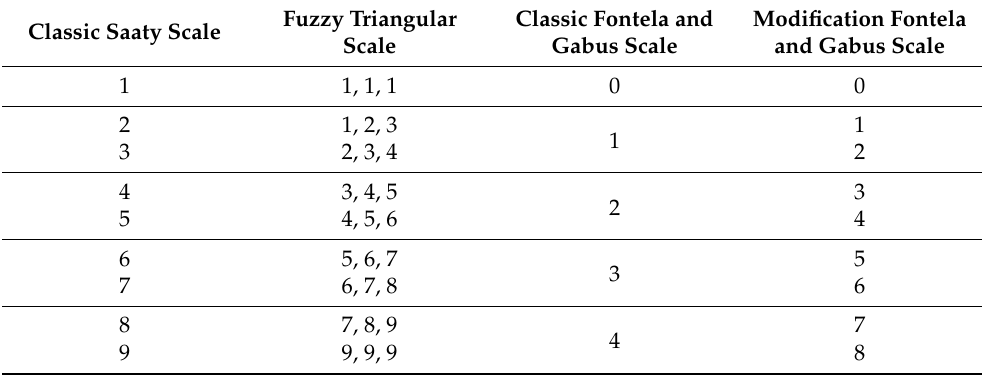
Table 1. An example of how to combine the scales used in the family of AHP and DEMATEL methods. Fuzzy Triangular Classic Fontela and Modification Fontela Classic Saaty Scale Scale Gabus Scale and Gabus Scale 1, 1, 1 0